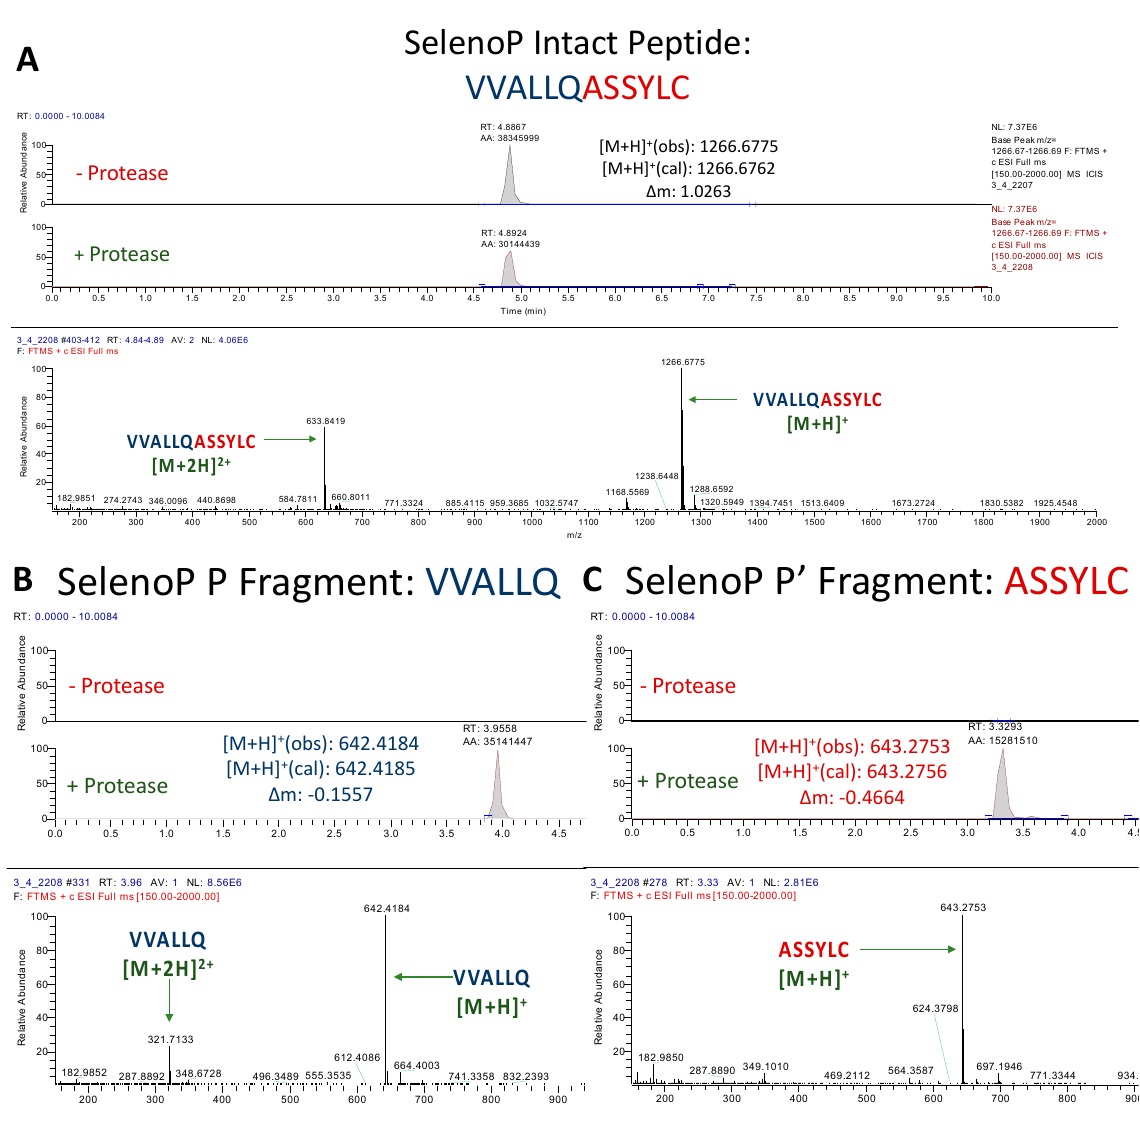
Figure 5. UPLC-MS Data for SelenoP Peptide. Depicted are the extracted ion chromatograms for the samples without protease and with protease (top) and the mass spectra (bottom) for ( A ) the Intact Peptide, ( B ) the P Fragment, and ( C ) the P ′ Fragment. Normalization levels of the base peaks for the P and P ′ fragments were 2.81 × 10 6 and 8.56 × 10 6 , respectively. High resolution mass spectrometric analysis corroborates the identities of each base peak in the corresponding extracted ion chromatogram.